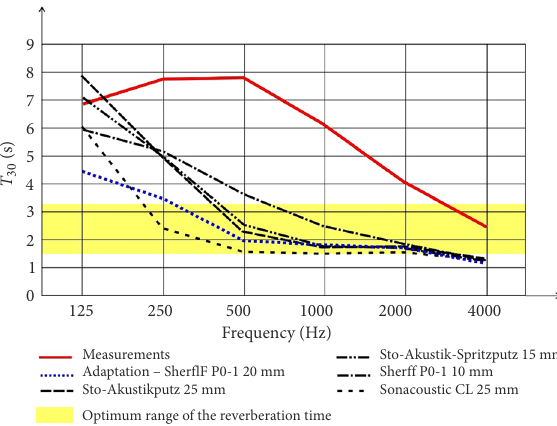
Figure 10. Graph of reverberation time T 30 in the frequency function for different types of acoustic plaster